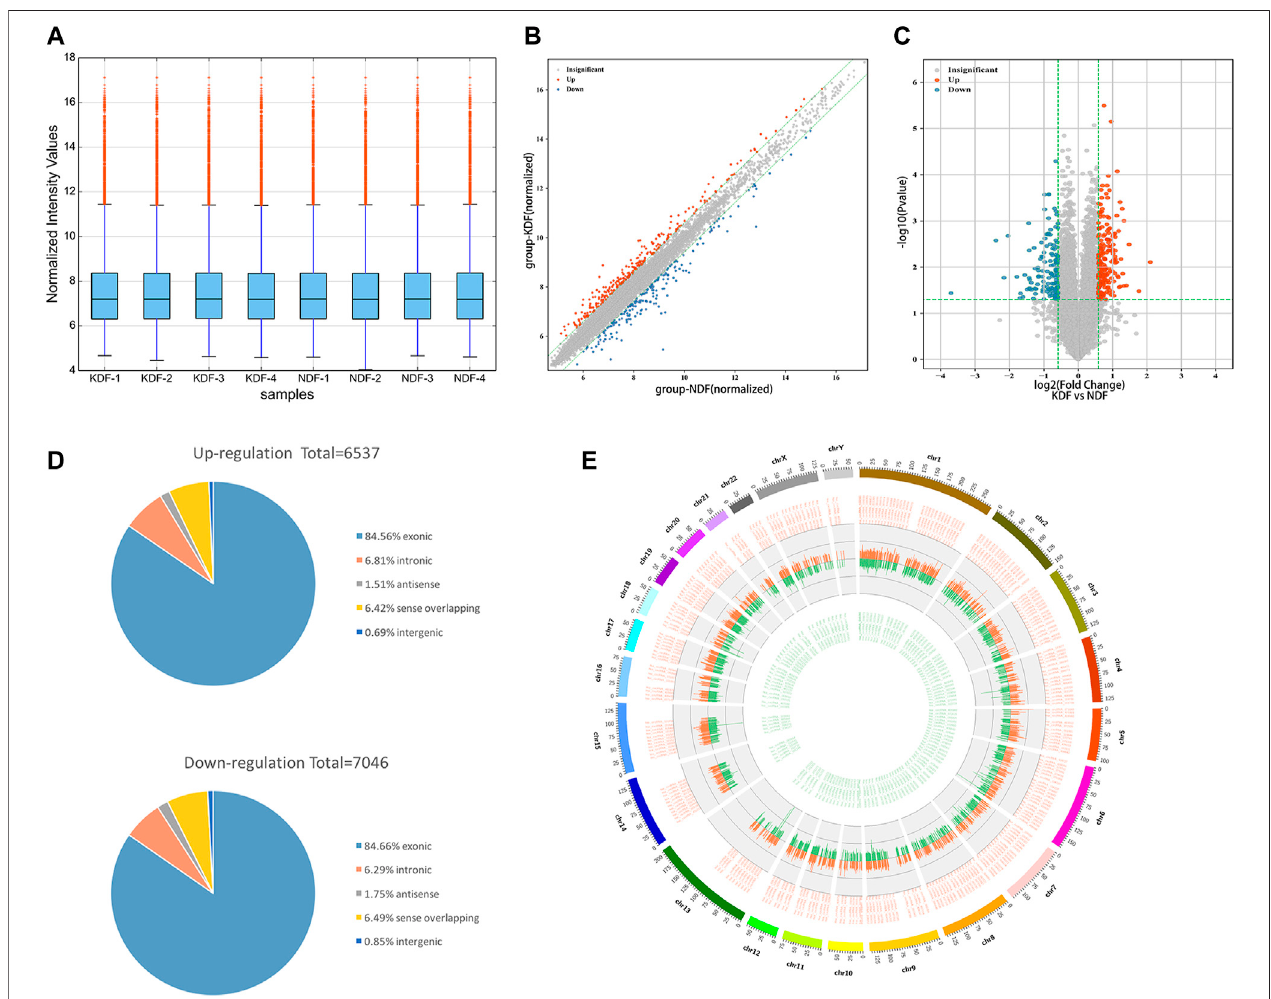
FIGURE 2 | Expression pro fi les and characteristics of circRNAs in KDF and NDF samples as examined by microarray. (A) The box plot shows the distributions of the expression values after quantile normalization. (B) The scatter plot shows the difference in circRNA expression between KDFs and normal controls. The red dots above the green line and blue dots below the bottom indicate a more than 1.5-fold change (FC) in circRNAs between the two compared groups. (C) Volcano plot of differentially expressed circRNAs (fold change > 1.5 and p < 0.05). The red and blue dots represent upregulated and downregulated circRNAs, respectively. (D) The circRNA classi fi cation statistics show the percentage of each type among all differentially expressed circRNAs. (E) The Circos diagram depicts the location of all differentially expressed circRNAs on chromosomes. The orange/red and green lines represent upregulated and downregulated circRNAs, respectively. The segment length indicates the FC